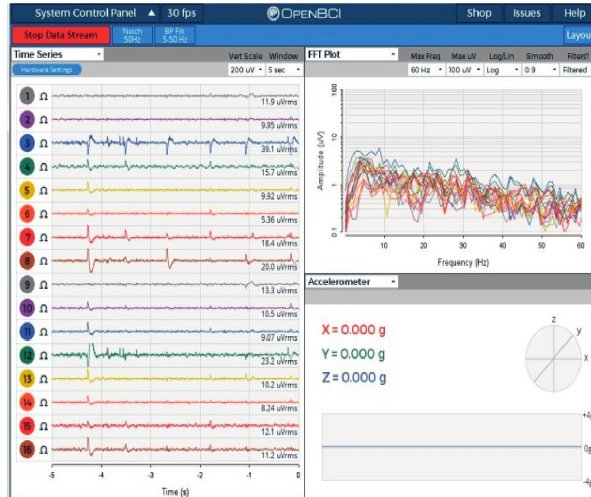
Figure 12: The EEG of pull action idea in the static state.